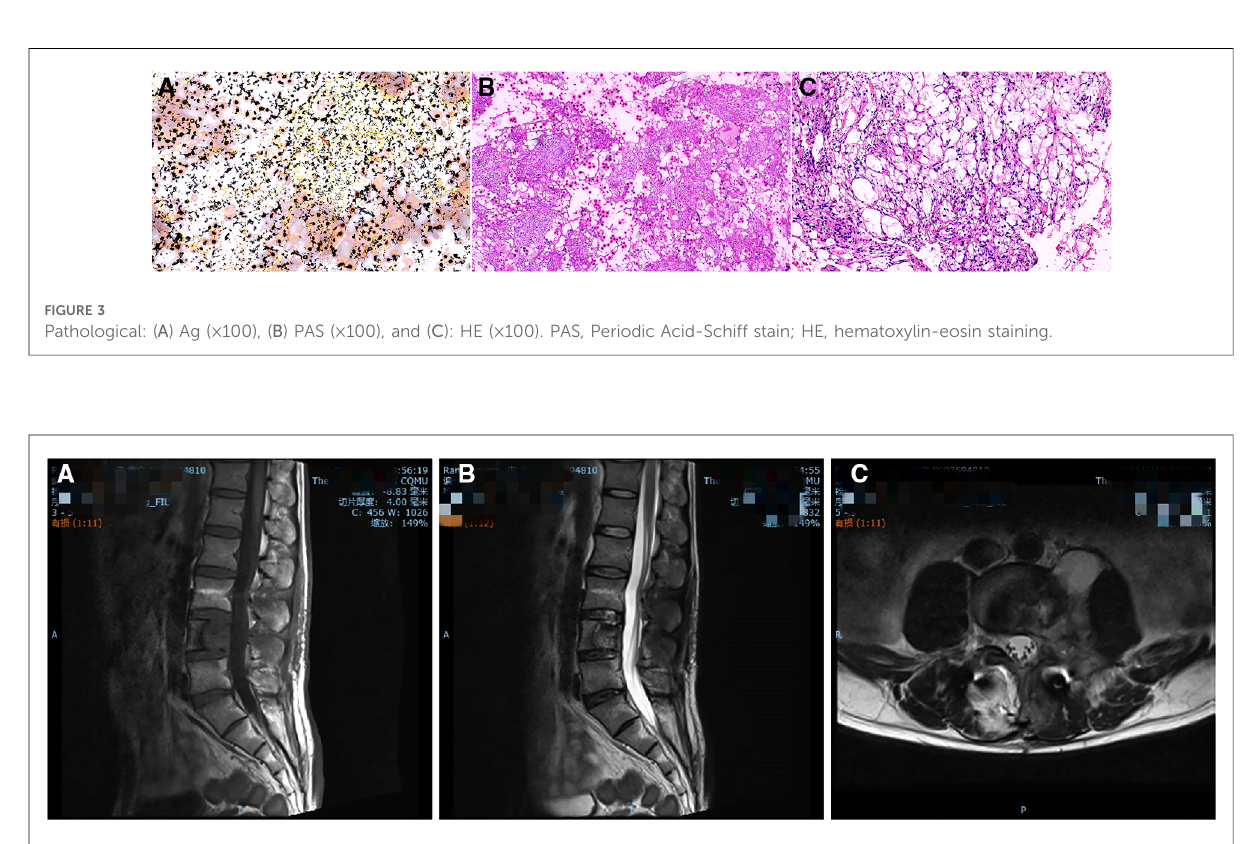
FIGURE 4 Twelve-month follow-up MRI shows a signi fi cant reduction of the lesion. ( A ) T1-weighted, ( B ) T2-weighted, and ( C ) axial